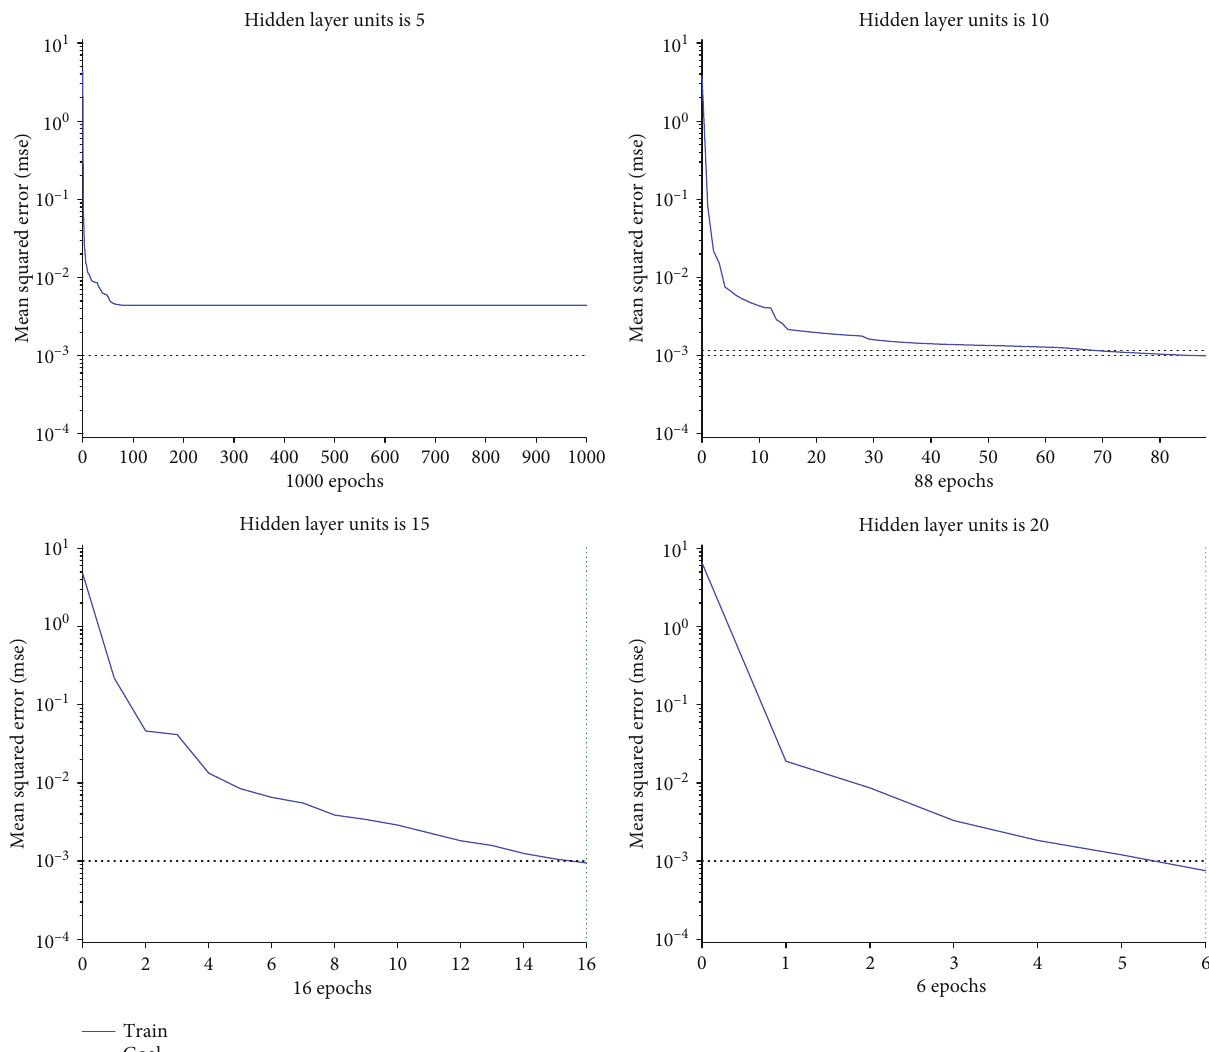
Figure 9: Performance of the BPANN with di ff erent hidden layer